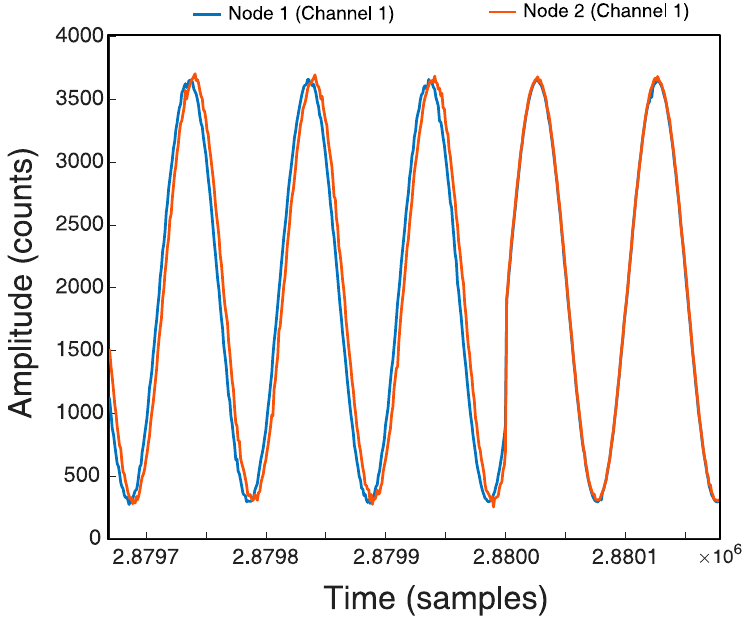
Figure 16. Sincronization with Stop-and-Go.